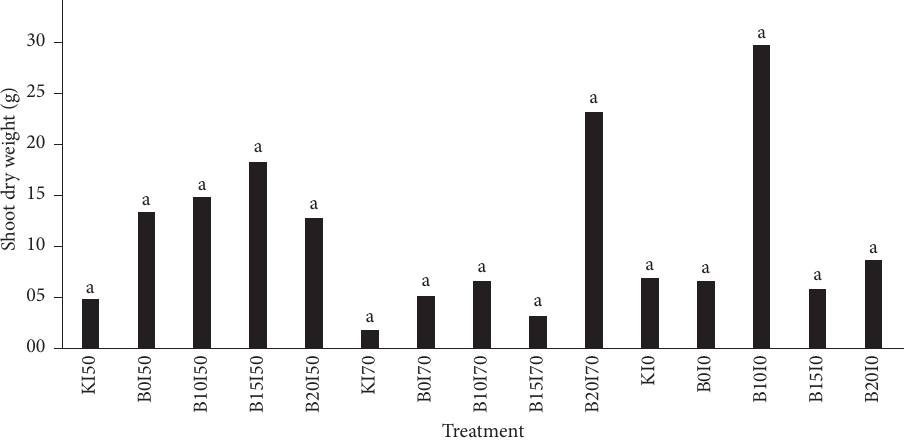
Figure 5: Shoot dry weight of longevity spinach ( Gynura procumbens ) plants as affected by biochar and shade